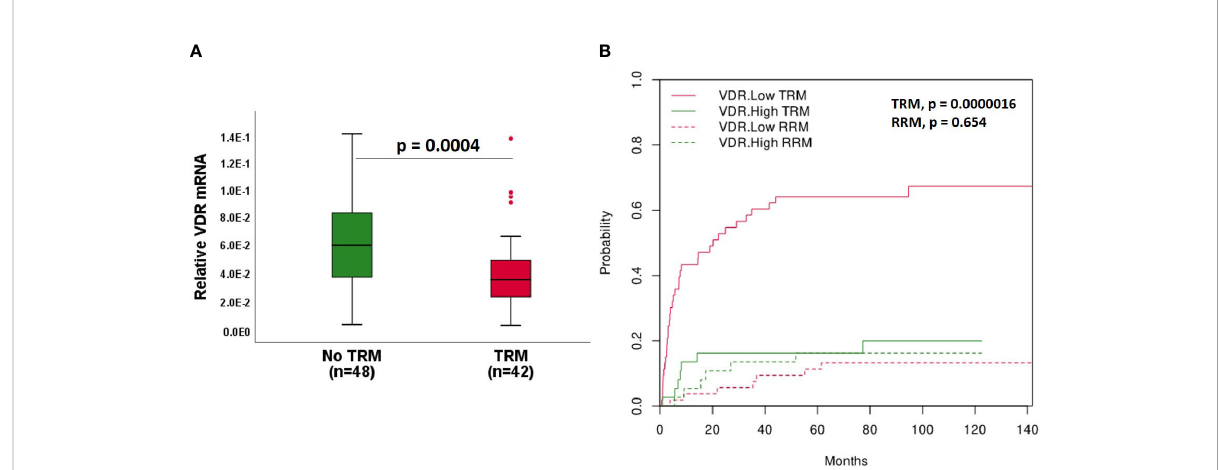
FIGURE 3 VDR expression with respect to TRM. (A) VDR gene expression in patients without and with TRM. Median survival time in: No TRM = 88 months, TRM = 11 months. (B) Association of VDR with cumulative incidence function estimates for competing risk data. Patients were classi fi ed according to high (green line) and low (red line) expression of VDR based on ROC curve. The cumulative risk of TRM and RRM with respect to months after biopsy retrieval is shown. Box plots represent the median, upper and lower quartile and whiskers indicate minimal and maximal values. p value, Mann-Whitney U test.